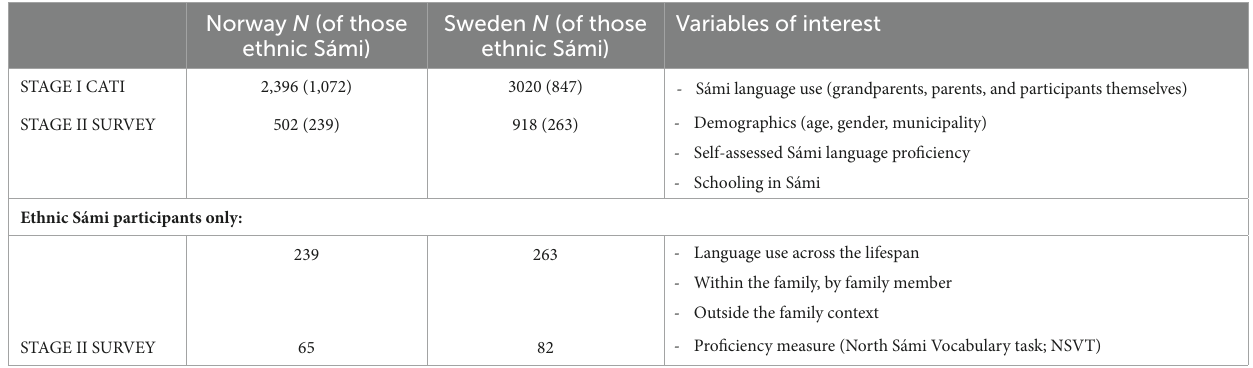
TABLE 3 Participation rates by survey stage, country, and variables of